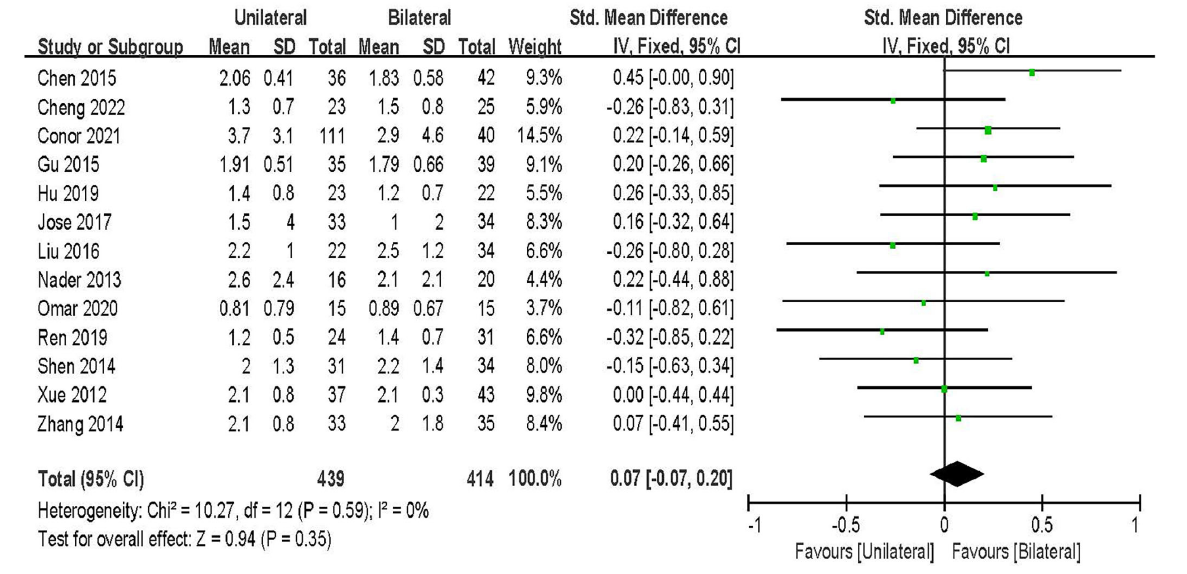
FIGURE2 Forest plot of VAS-Low back pain at final follow-up.